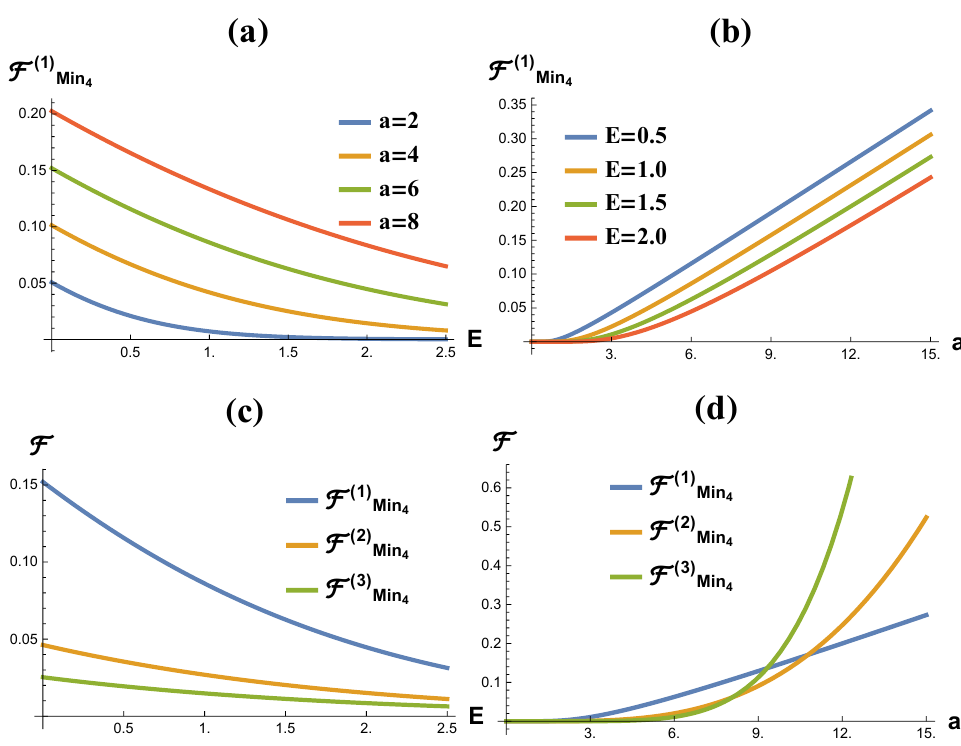
Figure 4 . Characteristics of four dimensional detector response function in flat spacetime with n = 1 as (a) a function of energy with different acceleration and (b) as a function of acceleration with different energy. Comparison on the effects of non-linearity on F Min and (d)